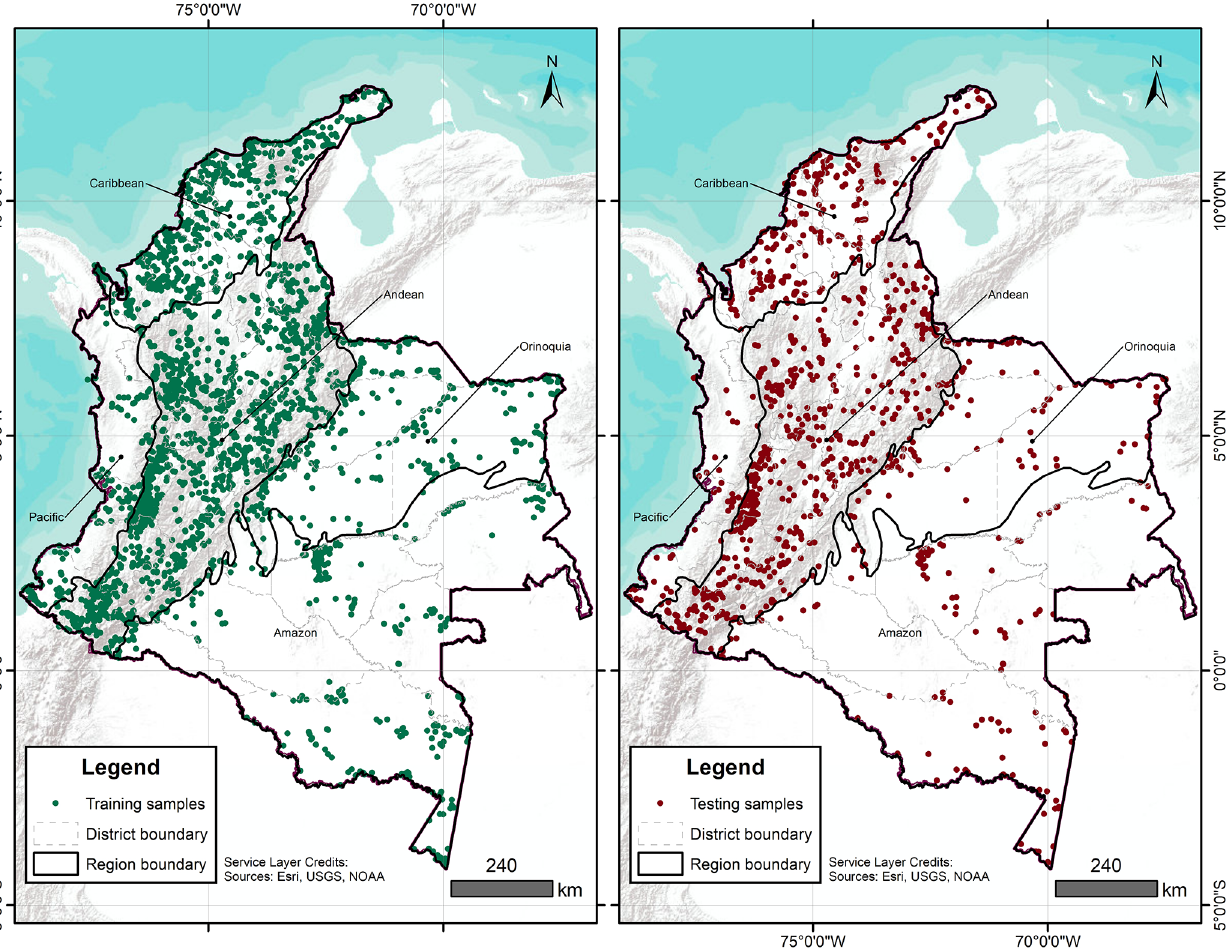
Figure 1. Soil sample points distribution at 0–5cm depth (left: training samples, right: testing